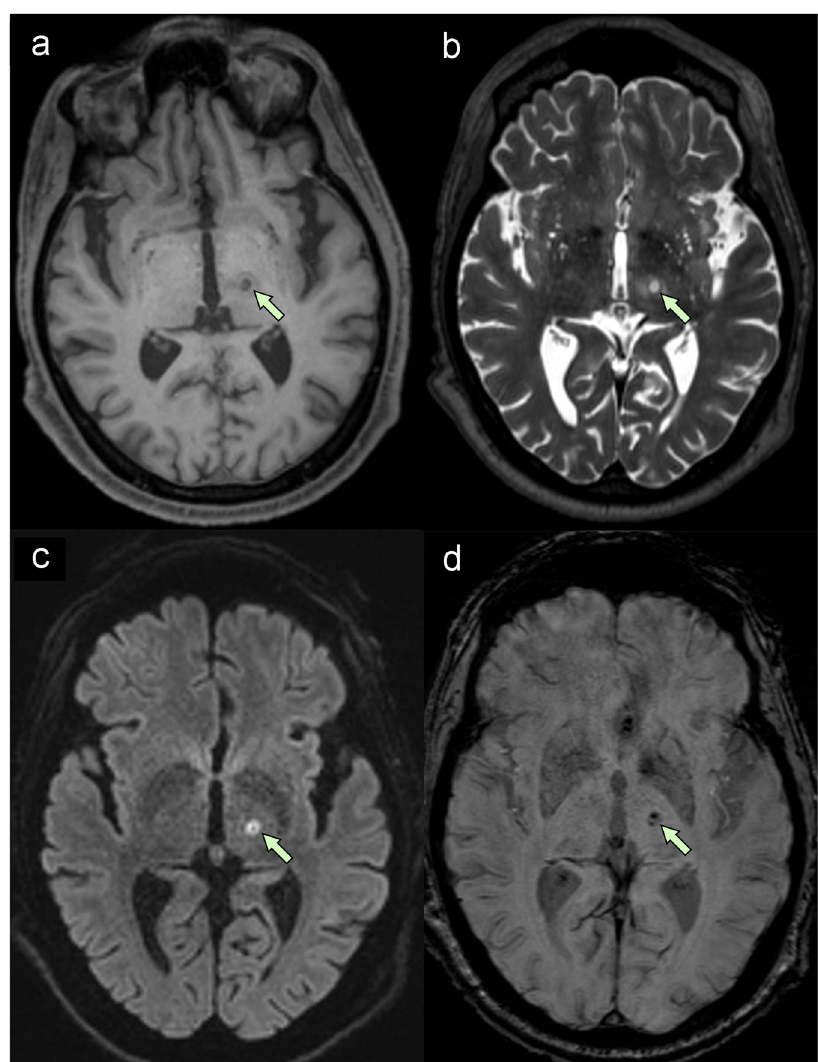
Fig. 1 Representative MRI on postoperative day 1. a T1-weighted image shows hypointense lesion in the thalamus. b T2-weighted image shows hyperintense lesion with a small hypointense core. c Diffusion-weighted image demonstrates diffusion restriction within the lesion, suggesting tissue infarction. d Susceptibility-weighted image demonstrates hypointense blood products within the